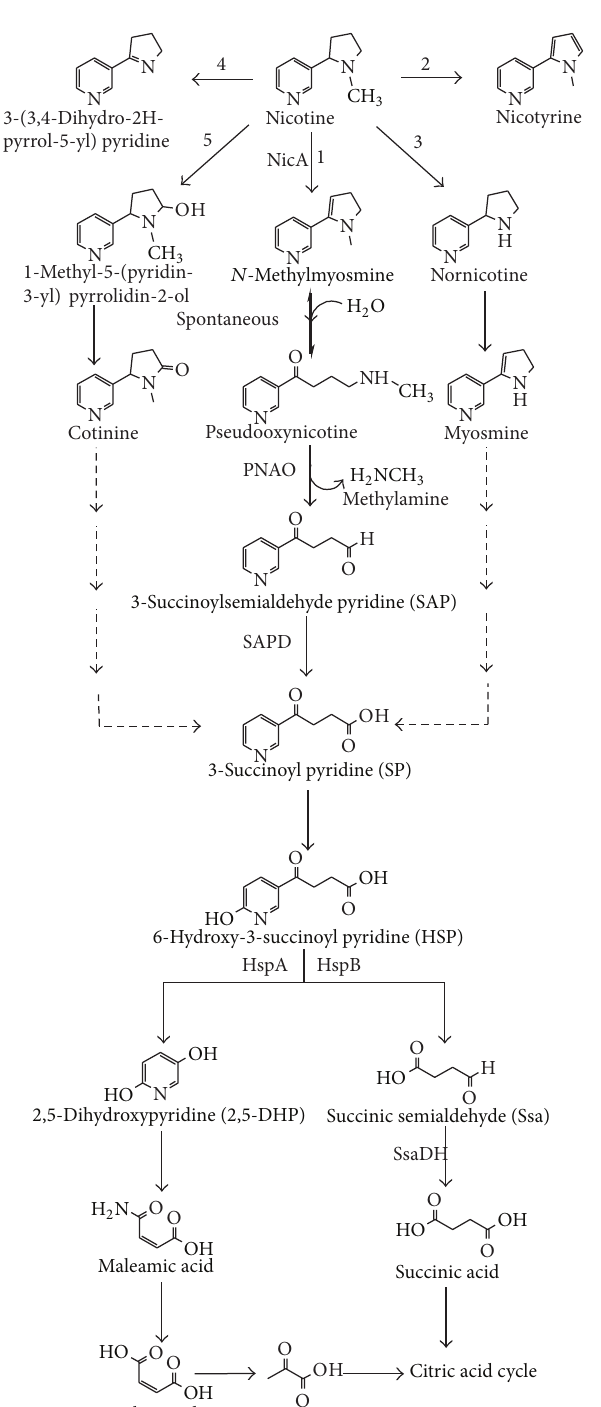
Figure 2: Various pyrrolidine pathways of nicotine degradation followed by 1. Pseudomonas sp. HZN6 and P. putida S16; 2. Pseudomonas sp. HF-1; 3. Pseudomonas sp. HF-1 and Pseudomonas sp. Nic22; 4. Pseudomonas sp. HF-1, Pseudomonas sp. Nic22, and Pseudomonas sp. CS3; 5. Pseudomonas sp. CS3. NicA, nicotine oxidoreductase; PNAO, pseudooxynicotine amine oxidase; SAPD, 3-succinoylsemialdehyde pyridine dehydrogenase; HspA and HspB, 6-hydroxy-3-succinoyl pyridine